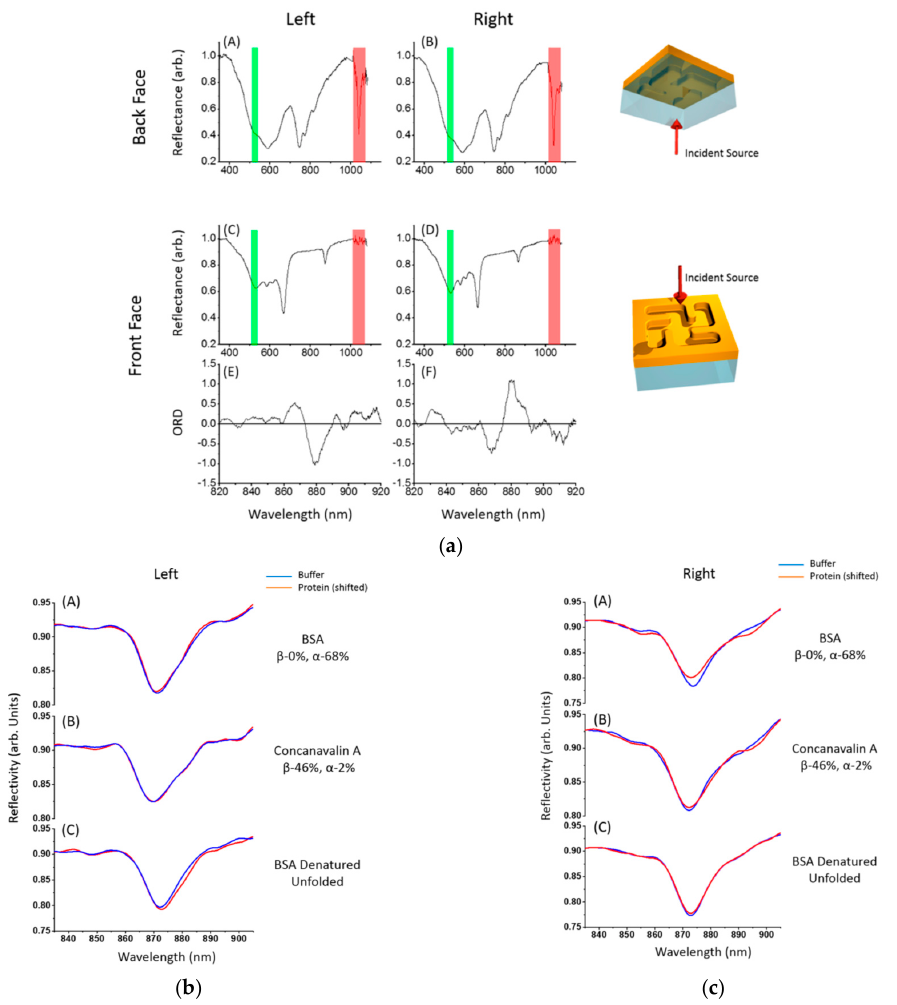
Figure 6. ( a ) Reflectance of left-handed and right-handed structure from back face and front face illuminations, and the ORD is plotted for front face illumination. Red bar represents the laser source, and green bar represents the second harmonic generation (SHG). Reflectivity of 3 types of proteins are plotted for ( b ) left-handed structure and ( c ) right-handed structure. Adapted from [87], with permission © 2016 American Chemical Society.